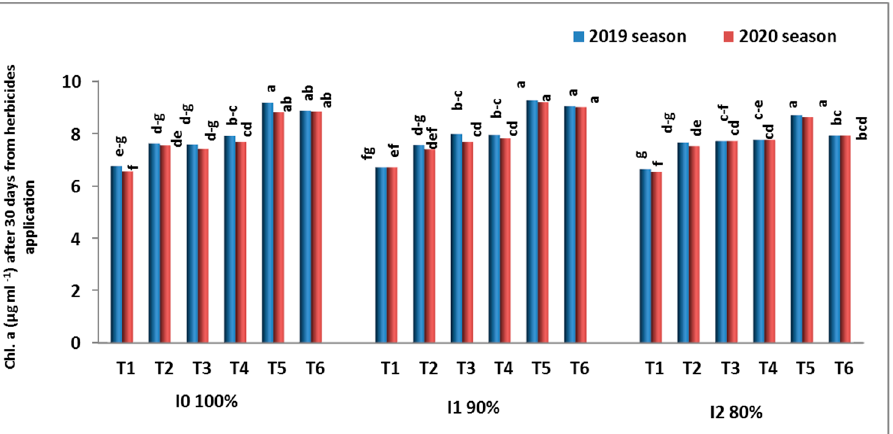
Figure 4. Effect of interactions between irrigation levels and weed control treatments on chlorophyll a content after 30 days from application during the 2019 and 2020 seasons. I 0 : 100% irrigation level T 1 : pendimethalin CS 45.5% T 4 : imazethapyr WG 60%; I 1 : 90% irrigation level T 2 : oxyfluorfen EC 24% T 5 : hand-hoeing twice; I 2 : 80% irrigation level T 3 : bentazon AS 48% + clethodim EC 12.5% T 6 : untreated check. Different letters represent significant differences (0.05).